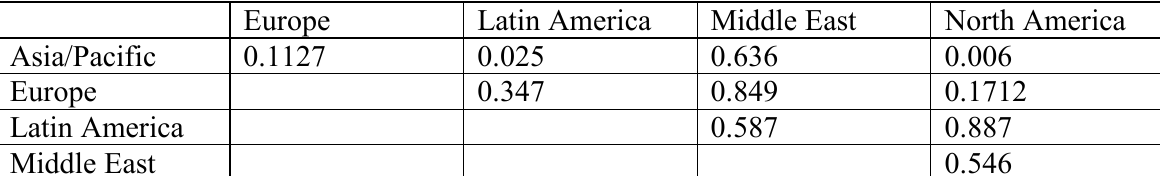
Table A3.7. GLMM model results for pairwise comparisons examining differences in the proportion of all plants that were crops based on region of national origin of gardeners. Numbers show p-values for pairwise comparisons of different levels for reach